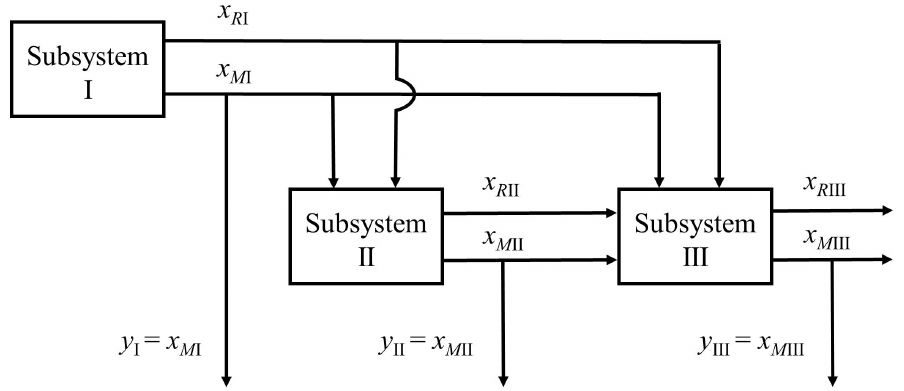
Figure 1. General structure of a system in lower block triangular (LBT) form with three